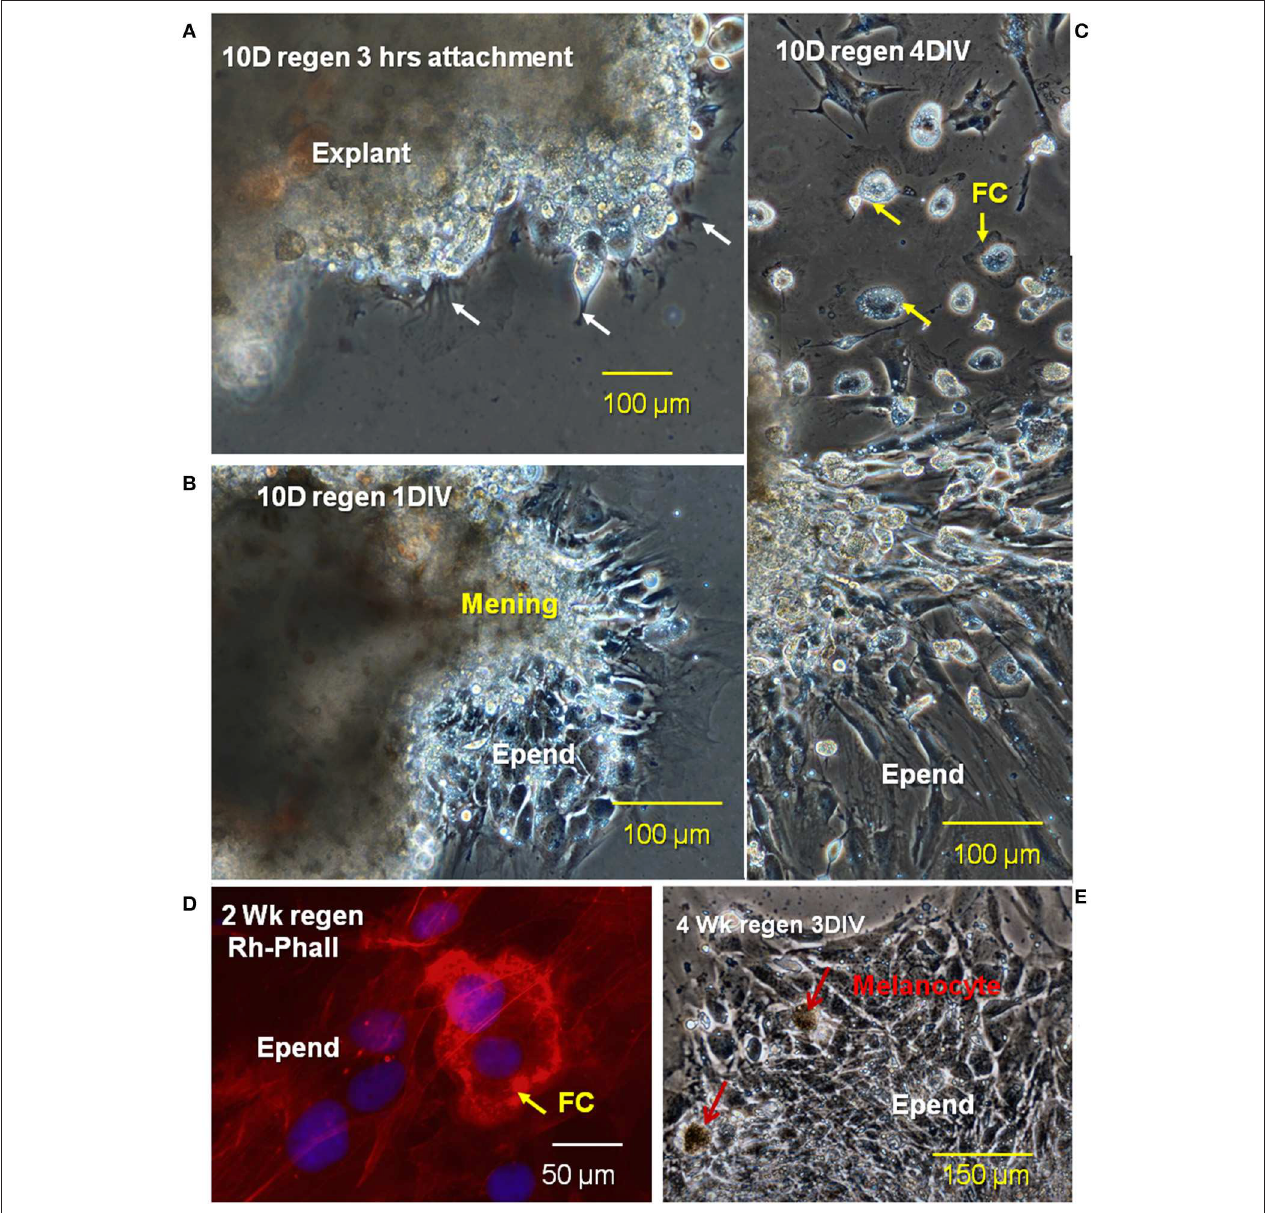
FIGURE 13 | Stages of migration of ependymal and foam cells from lesion site explants in vitro . Phase images of a 10D regenerating cord explant showing three different stages of cellular outgrowth; (A) at 3h after the beginning of culture, the explant was firmly attached to the fibronectin-coated dishes and cellular processes begin to extend away from the edges of the explant (B) , after 1D in vitro (1DIV), ependymal cells are migrating out of explants, while meningeal tissue is spreading, (C) after 4DIV, there is extensive dispersed ependymal outgrowth as well as foamy macrophages on and among the ependymal cells (D) . Rhodamine-phalloidin label of a cultured 2 weeks regenerating cord (red) showed the sealing ring of a foamy macrophage (FC arrow). (E) Cultured 4 weeks regenerates showed no foamy cells attached to ependymal cells. Regen, regenerating; hrs, hours; D, day; DIV, days in vitro ; mening, meningeal cells; Epend, ependymal cells; Rh-Phall, rhodamine-phalloidin. Magnification bar is shown in the lower portion of each image.